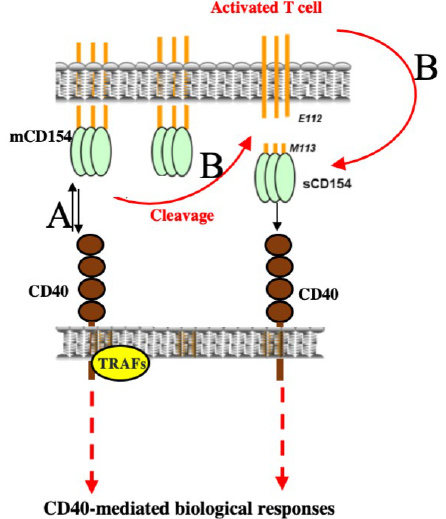
Figure 1. The bidirectional interaction of CD154 with CD40 induces CD154 cleavage and CD40- mediated biological responses . CD154 expressed on the surface of T cells (membrane-bound, mCD154) is capable of binding to CD40 and inducing a bidirectional intracellular signaling cascade and subsequent biological responses in both CD40-positive and CD154-positive cells ( A ). In order to put a halt to the CD154–CD40 biological response, CD154 expressed on the surface of T cells is cleaved into soluble CD154 (sCD154) upon its binding to CD40. Soluble CD154 may be also released from the intracellular milieu ( B ). Both mCD154 and sCD154 are capable of binding and activating CD40 inducing biological responses in CD40-positives cells. Engaging CD40 induces recruitment of TRAFs, i.e., TRAF1, TRAF2, TRAF3, TRAF5, and TRAF6, and subsequent triggering of intracellular signaling events. Abbreviation: TRAF, TNFR-associated factor. 3. CD40: The Classical CD154 Receptor CD40 is a 45–50 kDa phosphorylated type I integral membrane glycoprotein initially regarded as the only receptor for CD154 [15]. It is expressed on a variety of immune and non-immune cells including B lymphocytes, monocytes, macrophages, dendritic cells (DCs), fibroblasts, endothelial and epithelial cells, etc. [15,16,34,35]. The primary function of CD154 was believed to be only linked to humoral immunity via its interaction with CD40 [36]. Today, it is well-established that CD154 has a larger role than originally described, as it is involved in a variety of inflammatory immune responses [15,35]. CD40 is a transmembrane protein lacking direct intracellular enzymatic activity, hence its dependence on adaptor molecules for the proper relay of signals inside the cell, a function ensured by TNFR-associated factors, TRAFs. TRAFs 1, 2, 3, 5, and 6 have been shown to work with CD40 in its cell activation mission. Upon ligation of CD40 and its subsequent recruitment of TRAFs, several signaling cascades are triggered, activating nuclear factor κ B (NF κ B), mitogen-activated protein kinases (MAPKs) p38, and extracellular signal-regulated kinase 1/2 (ERK1/2), phosphatidylinositol- 3 kinase (PI-3K), Akt, c-Jun N-terminal kinase (JNK), STAT3, etc. [34,37–40]. Bidirectional signaling has